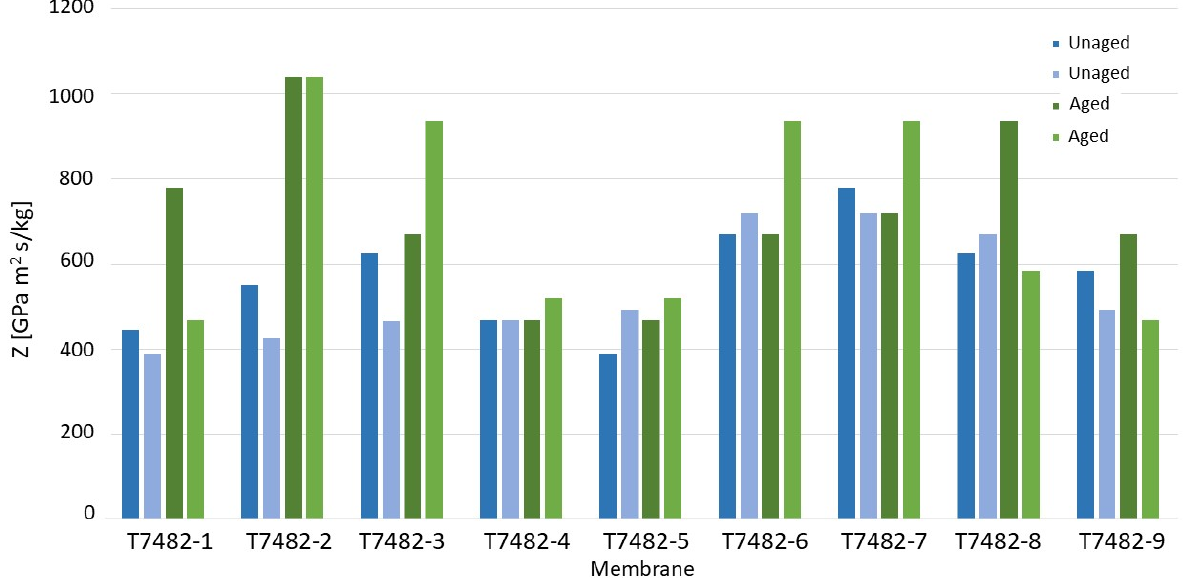
Figure 18. Water vapor diffusion resistance for the samples examined.